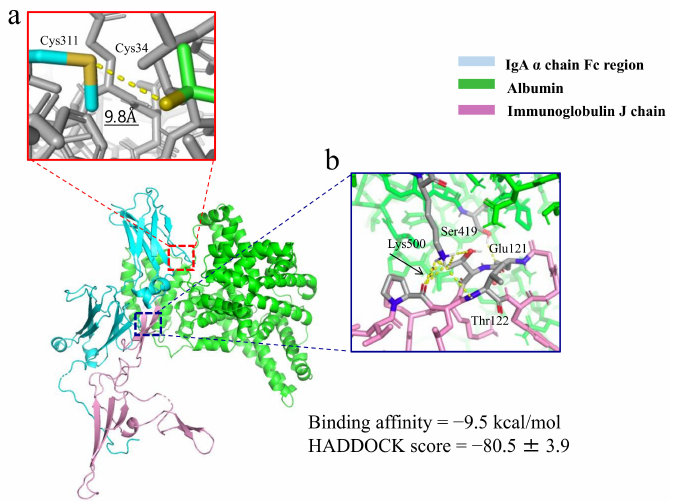
Figure 3. Predicted structure of the IgA-albumin complex (colored cartoon). In the enlarged panel, the Cys311 residue of IgA was in close proximity to the Cys34 residue of albumin ( a ). The other panel suggests that there are many noncovalent bonds between the J chain and albumin ( b ). An arrow indicates noncovalent